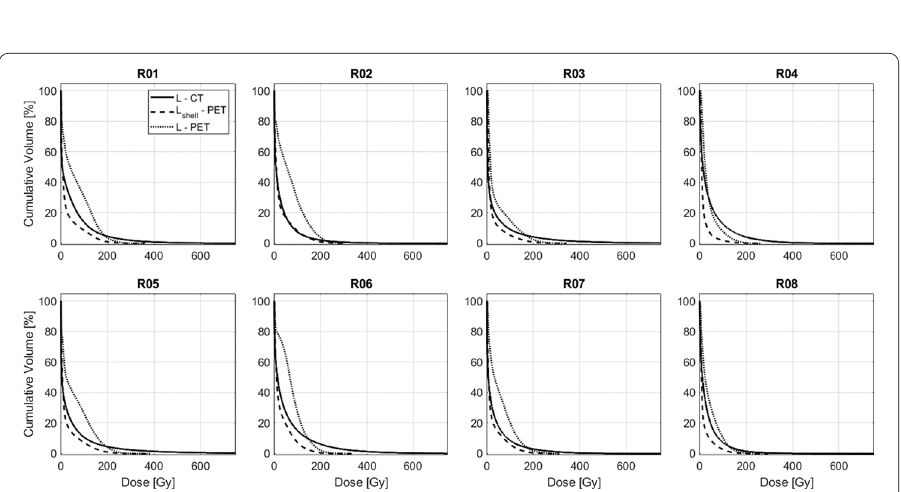
Fig. 13 Cumulative dose volume histograms (cDVHs) for the liver volumes L and L shell across all